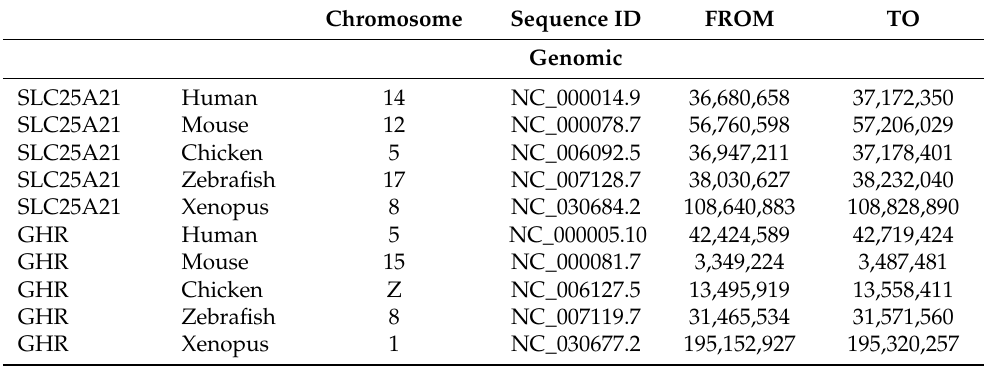
Table 2. The genomic sequences (NCBI Reference Sequence). Coverage: FROM the first nucleotide of the Start codon to the last nucleotide of the Stop